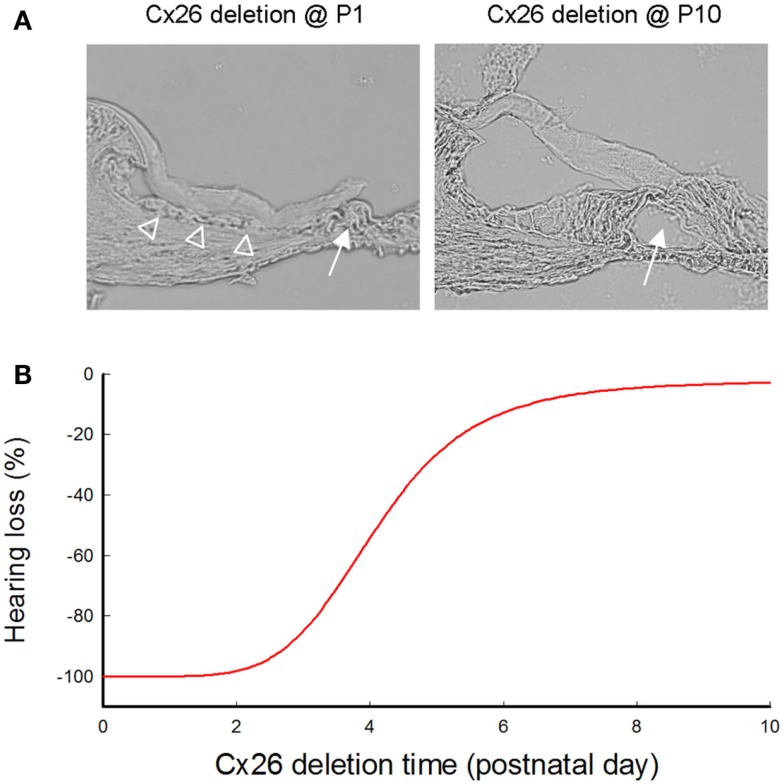
Cochlear developmental disorders and hearing loss induced by deletion of Cx26 in the cochlea at different postnatal times. (A) Cochlear development after deletion of Cx26 at P1 and P10. White arrows indicate that the cochlear tunnel is filled when Cx26 was deleted at P1 but developed normally when Cx26 was deleted at P10. Empty triangles indicate lack of the under-tectorial-membrane space; the tectorial membrane is attached to the inner sulcus cells following deletion of Cx26 at P1. (B) Hearing loss following deletion of Cx26 at different postnatal times. The ABR thresholds were measured at P30 and were normalized to that in WT mice. Corresponding to cochlear developmental disorders, deletion of Cx26 before P5 can induce severe hearing loss. However, hearing remains normal in young mice following deletion of Cx26 after P6. Modified from Chen et al. (2014).